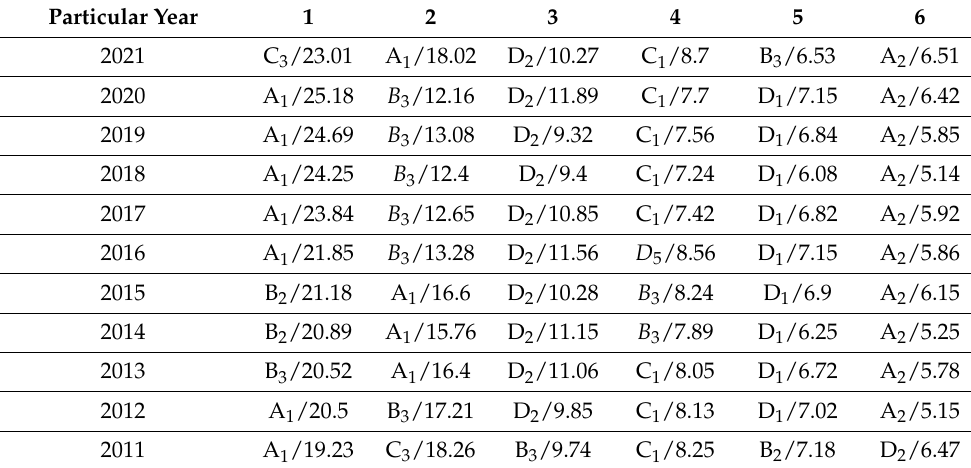
Table 4. Barrier Factor Analysis for the evaluation index